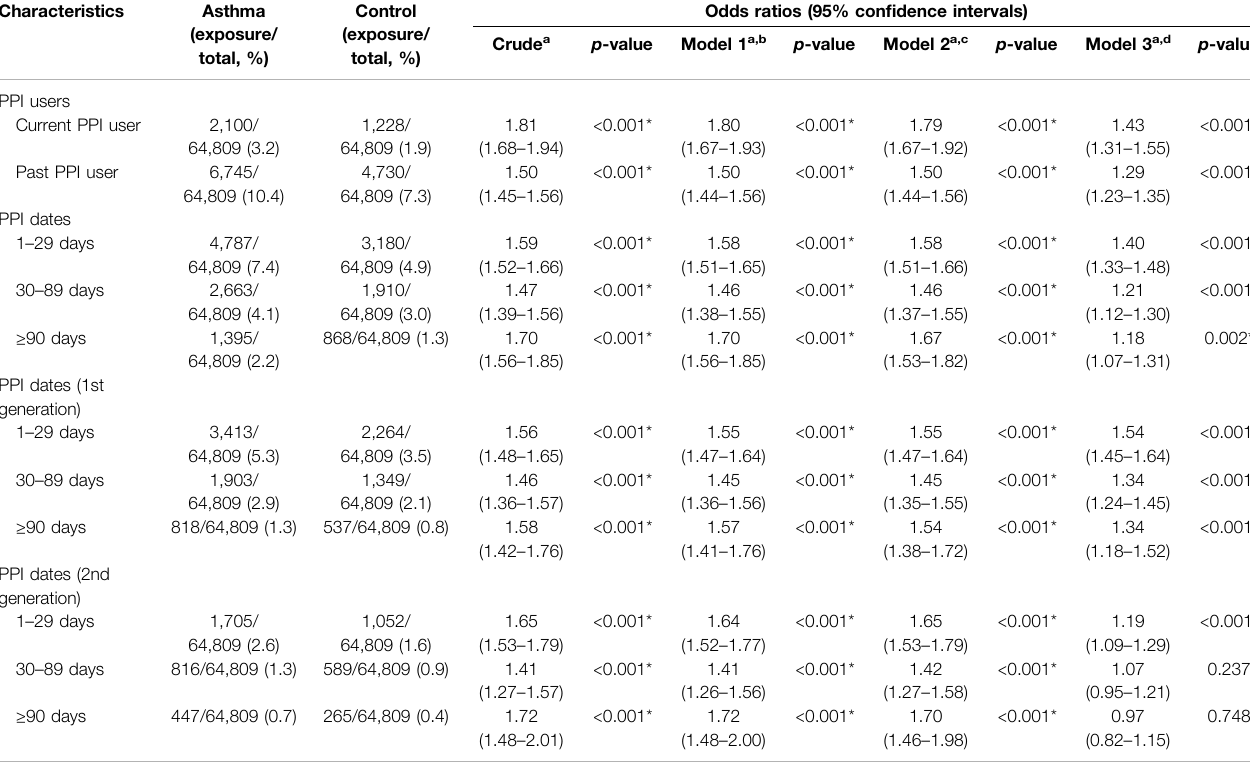
TABLE 2 | Odds ratios (95% con fi dence intervals) of PPI prescription history/PPI prescription dates/prescription dates of each generation of PPI for asthma.